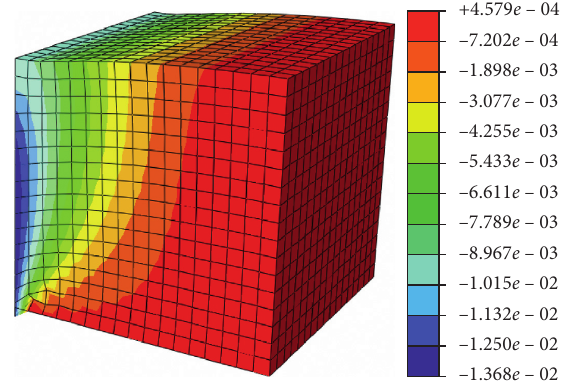
Figure 13: Vertical deformation contours of soil (unit: m).